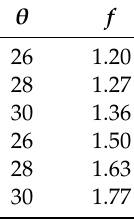
Table 2. Degree of overdrive f for different inflow Mach number M 0 and wedge angle θ .